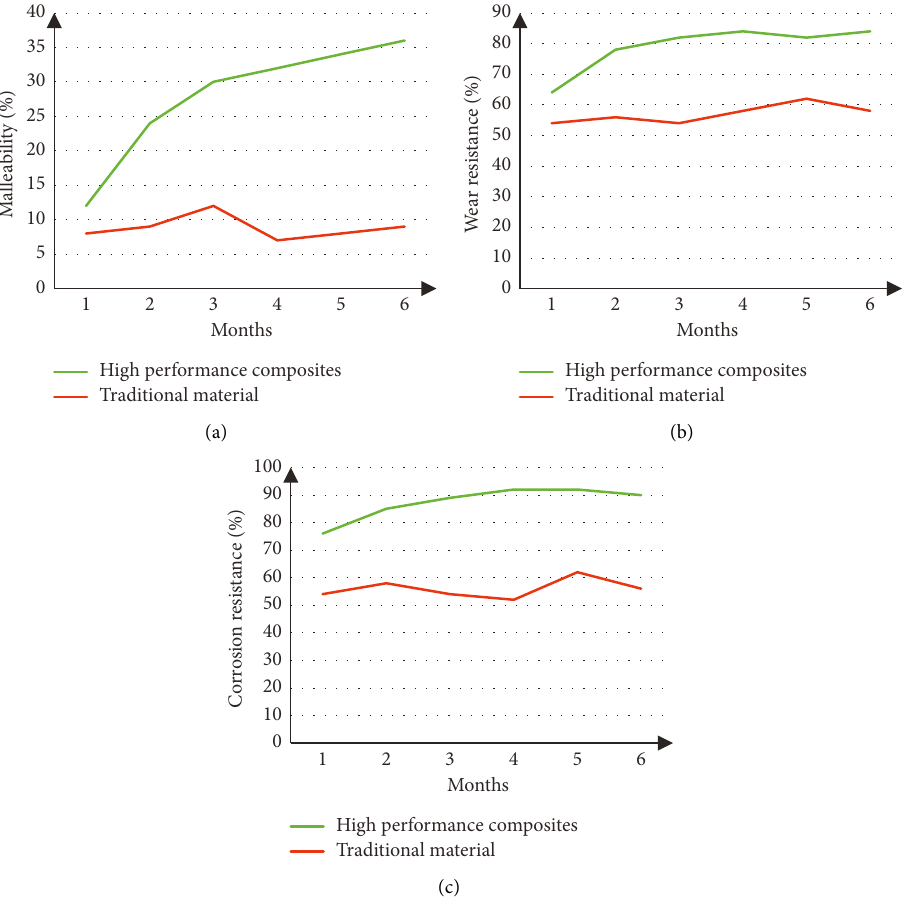
Figure 5: Results of quality comparison of sports equipment. (a) Ductility, (b) wear resistance, and (c) corrosion